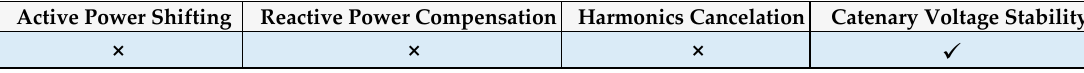
Figure 4. RPC operating in catenary voltage regulator mode (based on [40]). Table 2. Capabilities of the RPC operating in catenary voltage regulator mode.